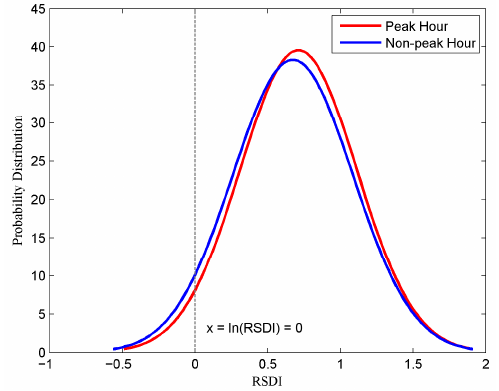
Figure 13. Normal distribution curve of rescue supply-demand index (RSDI).